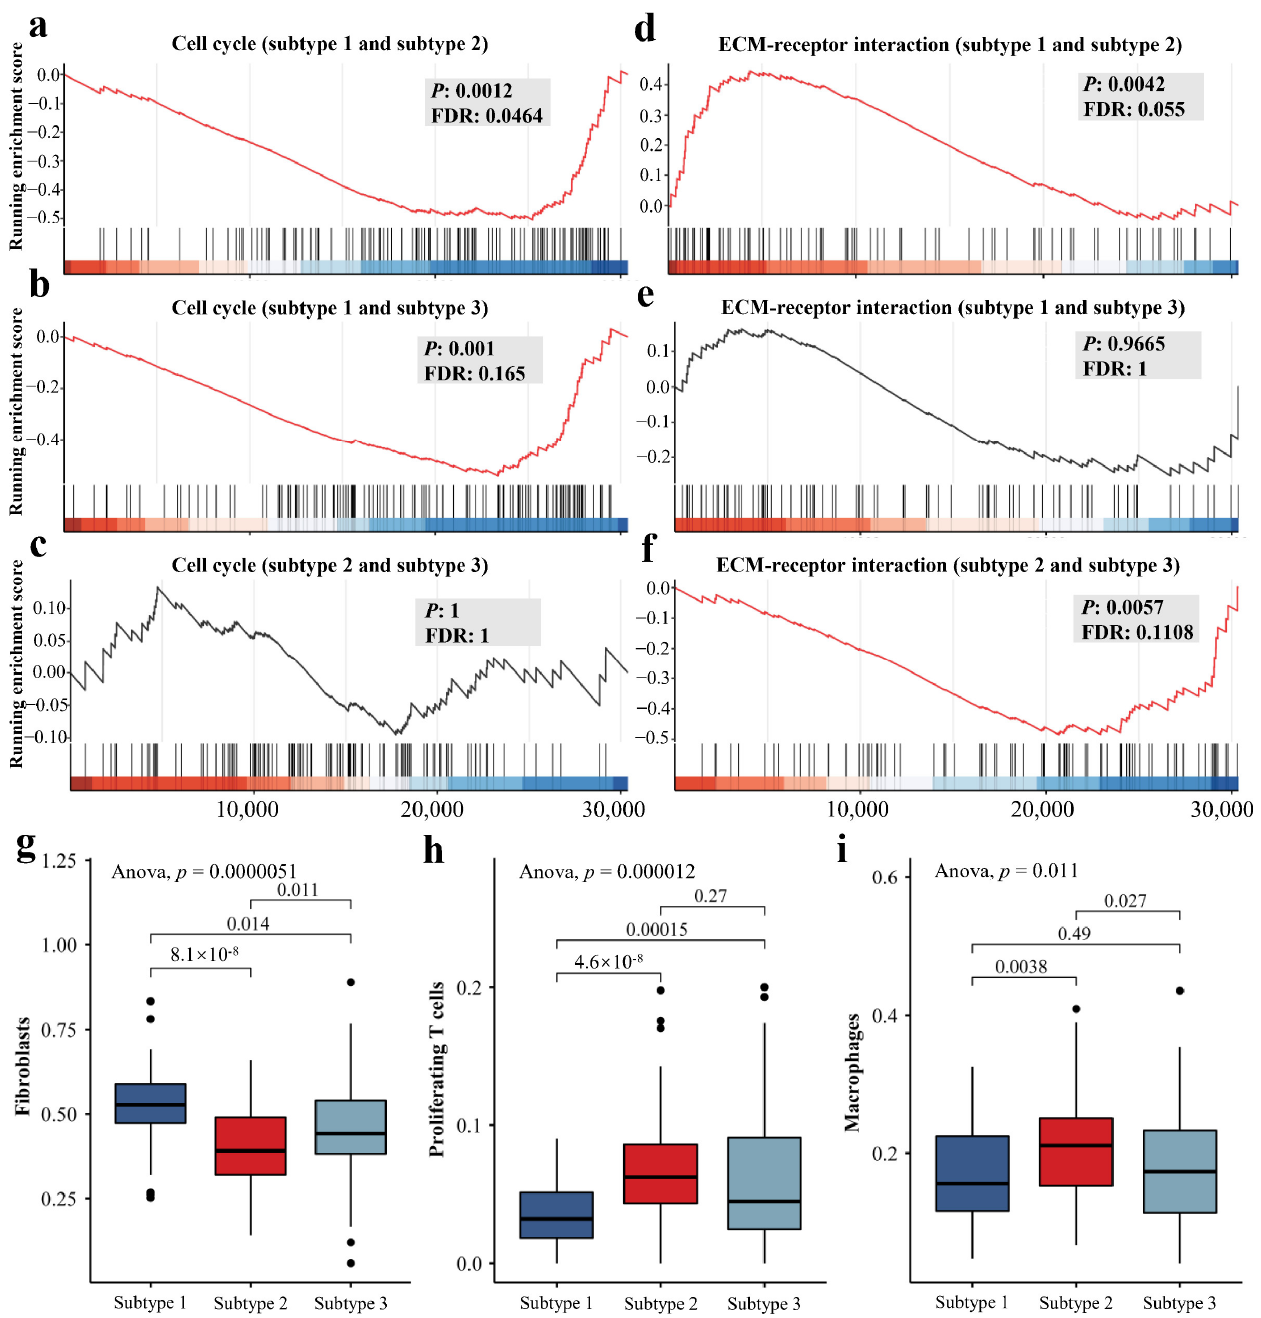
Figure 6. Important enriched KEGG pathways and tumor microenvironment characteristics of different DCE-MRI subtypes. Detailed differences in representative transcriptional behavior among three subtypes including cell cycle ( a – c ) and ECM-receptor interaction ( d – f ) are illustrated. The boxplots for the fractions of cancer-associated fibroblasts ( g ), proliferating T cells ( h ) and macrophages ( i ) among imaging subtypes in both discovery and validation cohorts are displayed. ANOVA was used to identify the differences in cellular fractions among three subtypes, and Student’s t-test was used for the comparison between two subtypes.